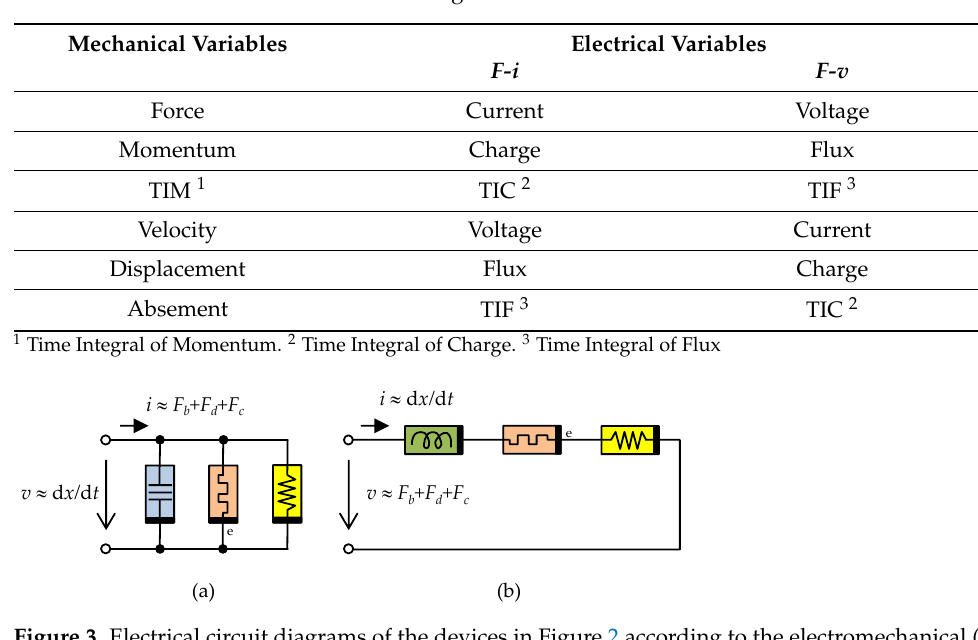
Figure 3. Electrical circuit diagrams of the devices in Figure 2 according to the electromechanical ( a ) F - i , ( b ) F - v analogy. Elements used: ideal memcapacitor (blue), ideal meminductor (green), extended memristor (red), and resistor (yellow).